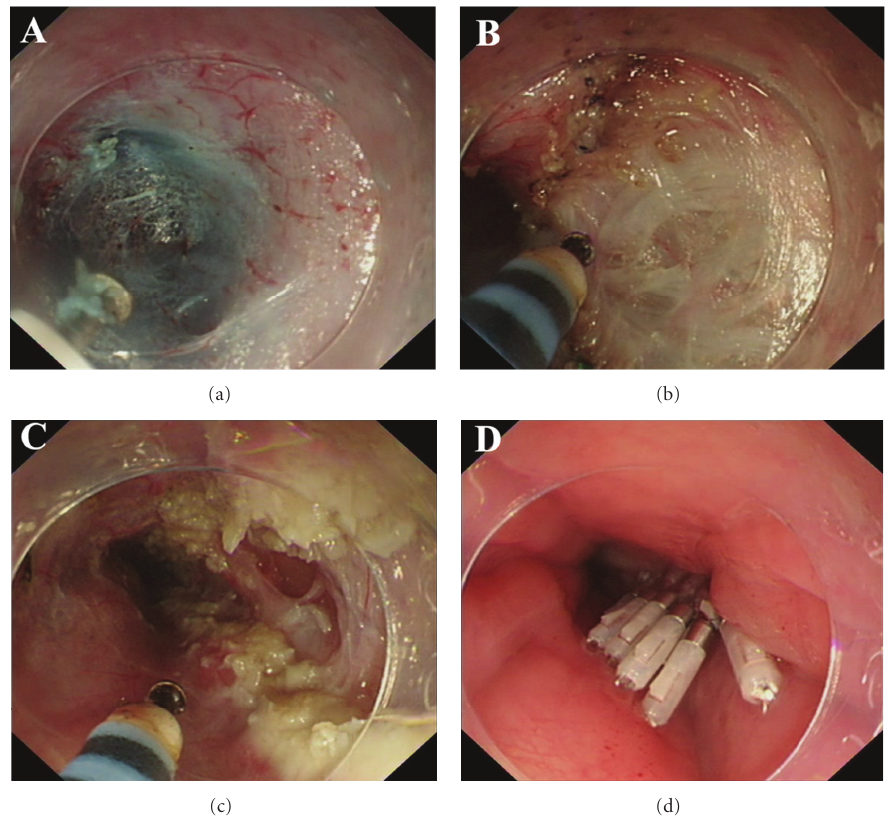
Figure 1: POEM procedures. (a) Creation of submucosal tunnel. A submucosal tunnel was created from the mucosal incision point (12cm above the GEJ) to 3 cm below the GEJ. The palisade vessels on the right half of the picture confirmed the tip of the cap-fitted endoscopy had reached GEJ. The underlying inner circular muscle can also be viewed. (b) Endoscopic myotomy. The inner circular muscle was transected while remaining the outer longitudinal muscle layer intact. (c) Completion of the endoscopic myotomy. The length of myotomy was 13cm (10cm above the GEJ to 3 cm blow the GEJ). (d) Closure of the mucosal entry point by clips.